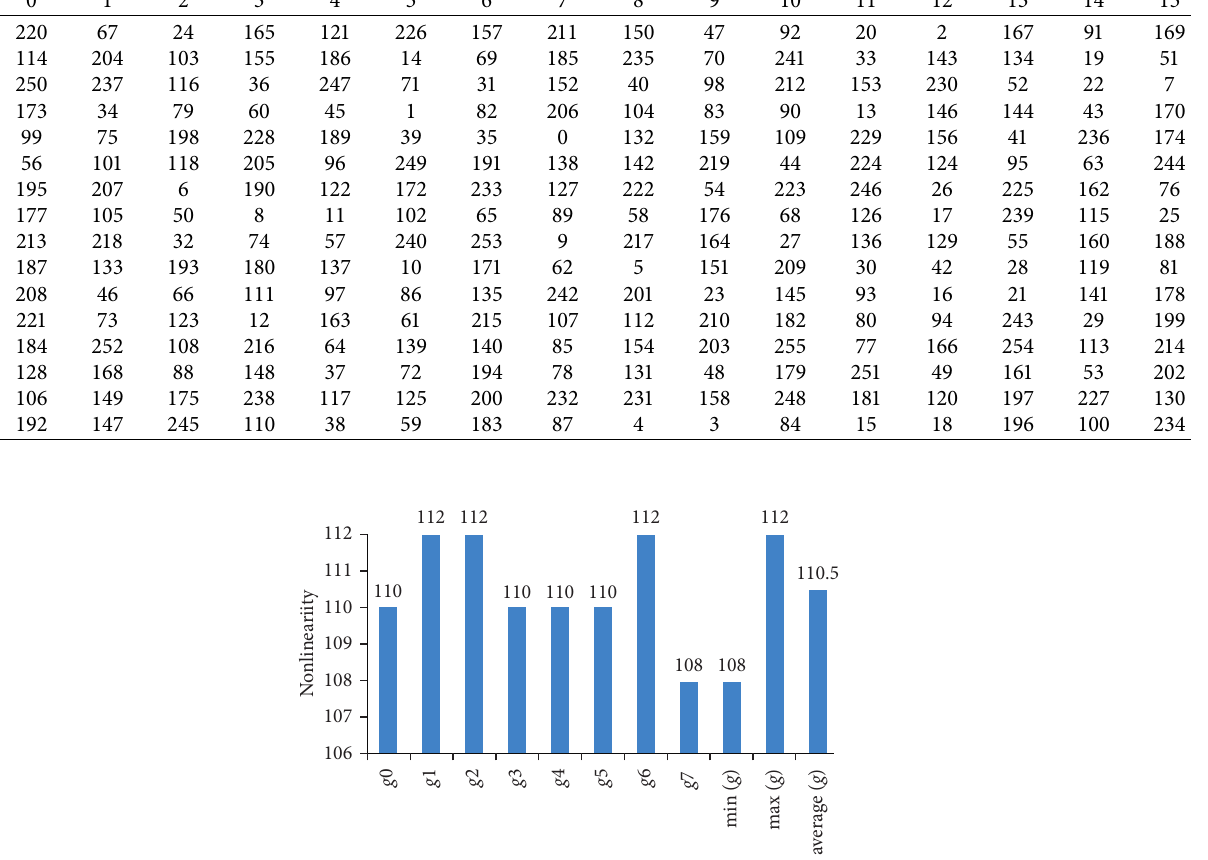
Figure 7: Nonlinearity scores of component Boolean functions of the proposed S-box. Table 4: Dependency matrix for proposed S-box’s SAC assessment.